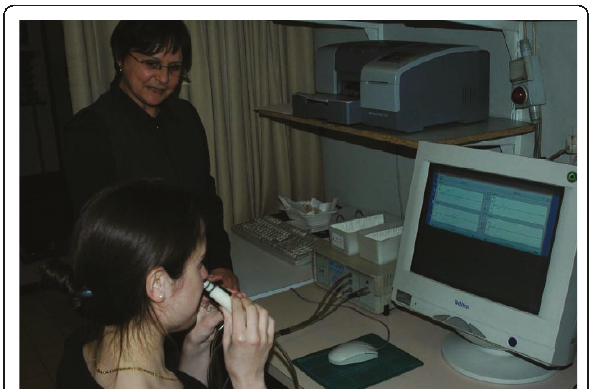
Figure 13 Active anterior rhinomanometry .